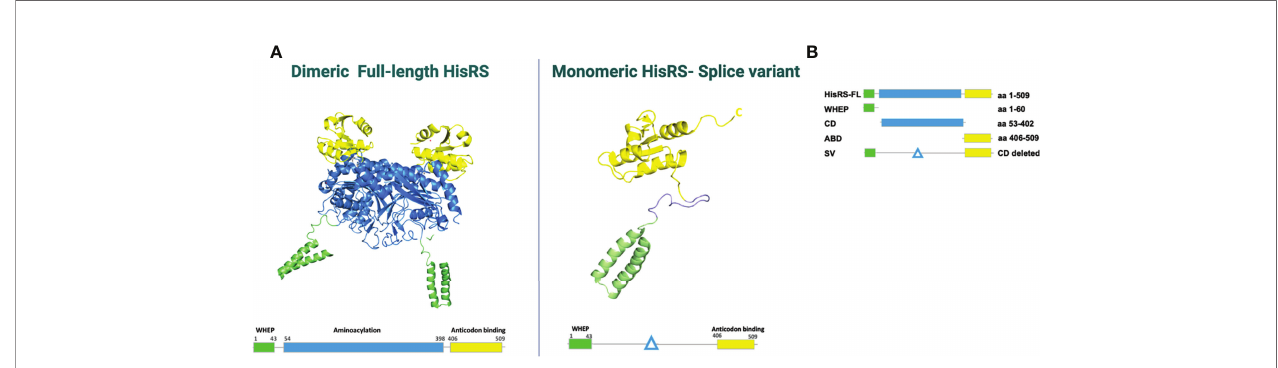
FIGURE 2 | (A) HisRS structure visualized using PDB ID: 4G84 and 2LW7 (98). (B) Schematic fi gure of HisRS constructs, adapted from Notarnicola et al. (99). HisRS-FL, HisRS-full length; WHEP, WHEP domain; CD, catalytic domain; ABD, anti-codon binding domain; SV,